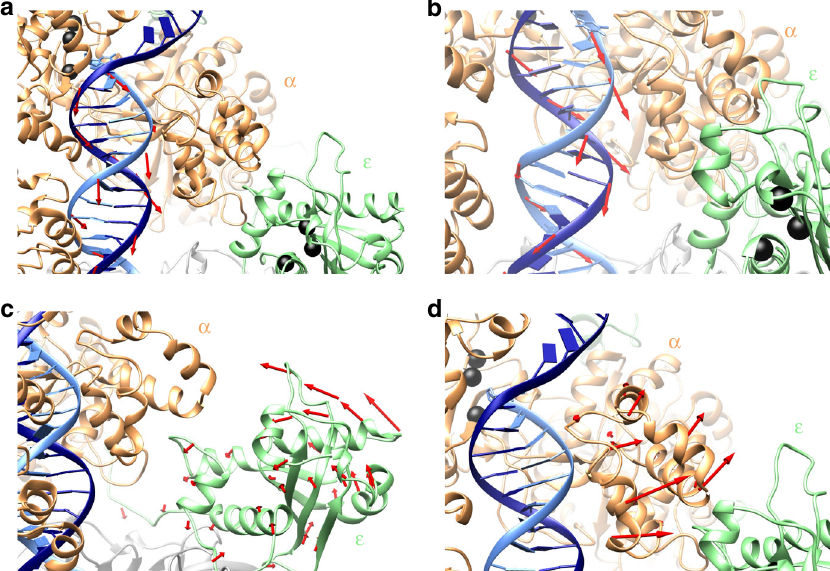
Fig. 2 Concerted motions of Pol III holoenzyme guide the primer along the path toward the exonuclease state. a Initial backtracking motion of the DNA duplex away from polymerase active site observed in the MEP. b Subsequent rotational motion of the DNA and additional backtracking facilitates sequential unpairing at the primer/template junction. c Tilting motion of the ε subunit toward the α subunit shortens the distance between the polymerase and exonuclease active sites. d Outward shift of the thumb domain with respect to the PHP domain creates an opening to accommodate repositioning of the ε subunit. Red arrows indicate direction of motions observed in the minimum free energy path (MEP). Shifts in atomic positions for consecutive replicas of the MEP during different stages of the pol-to-exo transition were computed as vectors and mapped onto the structural elements of the Pol III holoenzyme. The α subunit is shown in orange; the ε subunit is shown in light green; the primer and template DNA strands are shown in light and dark blue, respectively; residues in the pol and exo active sites are shown as black spheres. The θ subunit has been omitted for